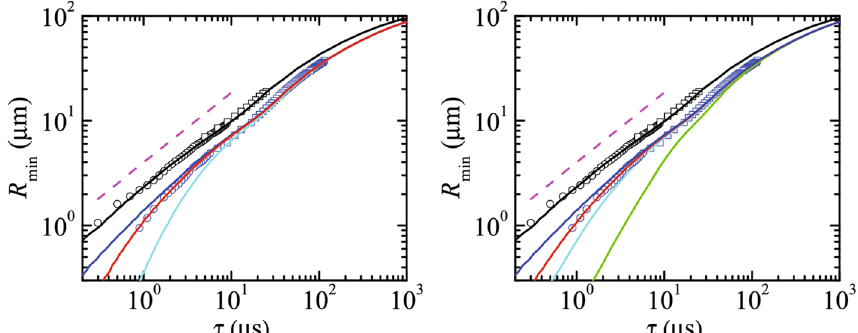
Figure 3. R min (τ) or the breakup of a pendant drop of DIW and DIW+SDS 0.8cmc. The black and blue symbols are the experimental data for DIW and DIW+SDS 0.8cmc, respectively. The different symbols correspond to experiments visualized with different magnifications. The black solid line and magenta dashed line correspond to the simulation and the power law R min (τ) ∼ τ 2 / 3 for DIW, respectively. (Left) The colored S ∗ 0 and µ S ∗ 0 (blue), 5 × 10 − 10 (red), solid lines correspond to simulations of DIW+SDS 0.8cmc for µ 1 = 2 = and 3.5 × 10 − 9 Pa s m (cyan). (Right) the colored solid lines correspond to simulations of DIW+SDS 0.8cmc S ∗ 0 and µ S ∗ 0 (blue), 3.5 × 10 − 9 (red) 10 − 8 (cyan), and 10 − 7 Pa s m (green). All the numerical for µ 1 = 2 = Ŵ cmc = 1.002 , and Pe S = 7.730 × 10 4 (see results were calculated for B = 3.396 × 10 − 3 , Oh = 0.01510 , S ∗ 0 and Oh S ∗ 0 (blue), “Methods” section). In the left-hand graph, the colored solid lines correspond to Oh 2 = 1 = (cid:31) 6.563 × 10 − 5 (red), and 4.594 × 10 − 4 (cyan). In the right-hand graph, the colored solid lines correspond to